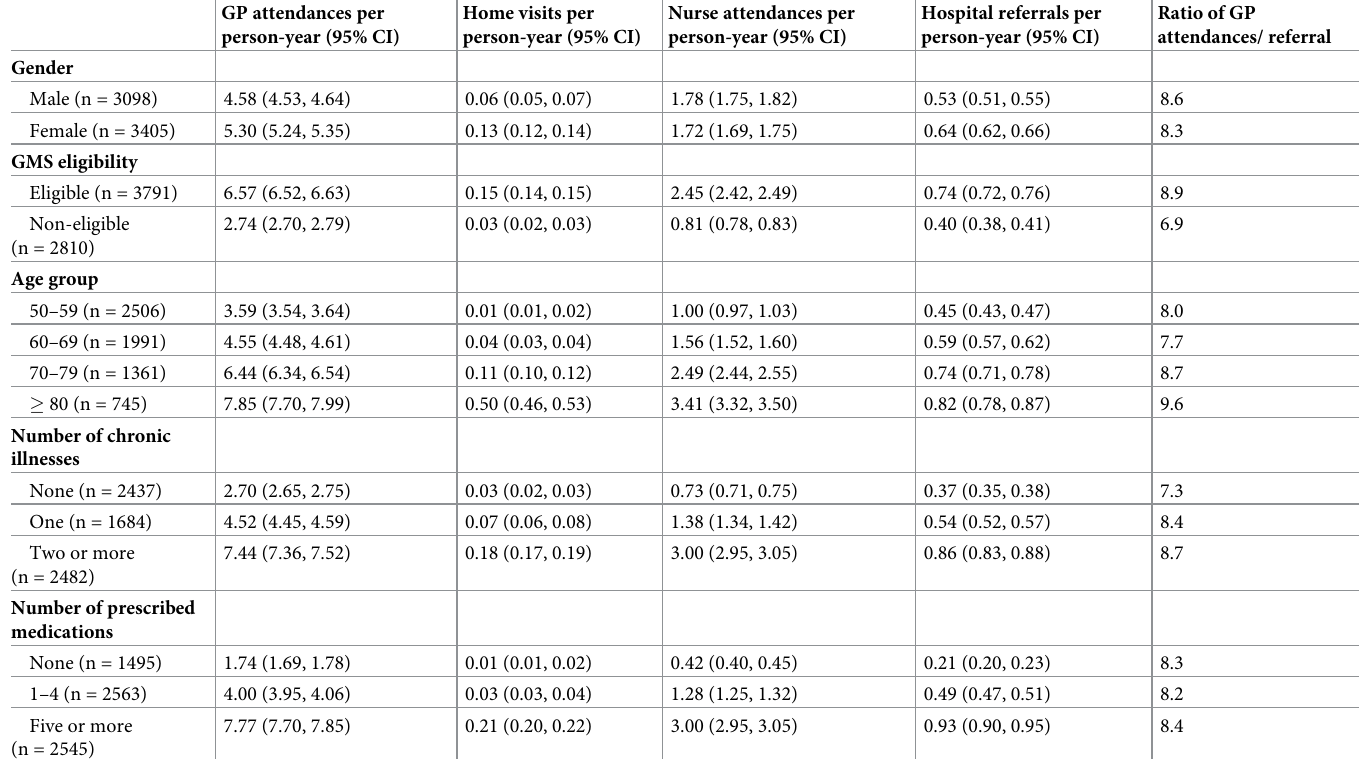
Table 3. Attendances and referrals by gender, GMS eligibility, age group, number of chronic illnesses and prescribed